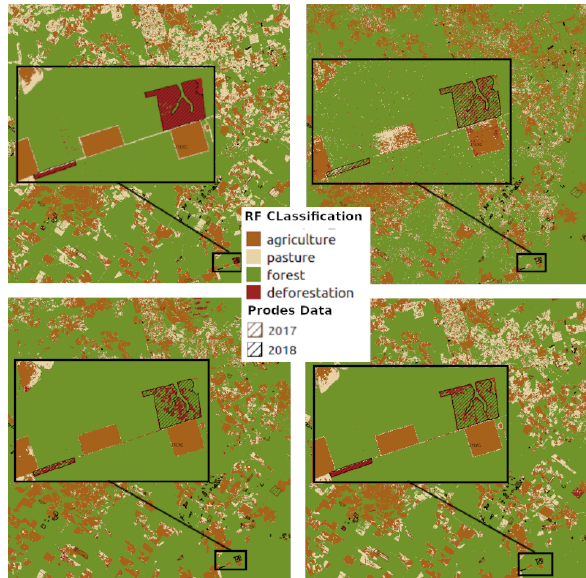
Figure 4. PRODES and RF Classification with indices NDVI (top-left), GEMI (top-right), EVI (bottom-left) and SAVI (bottom-right) at tile 21LYH of January 2018.